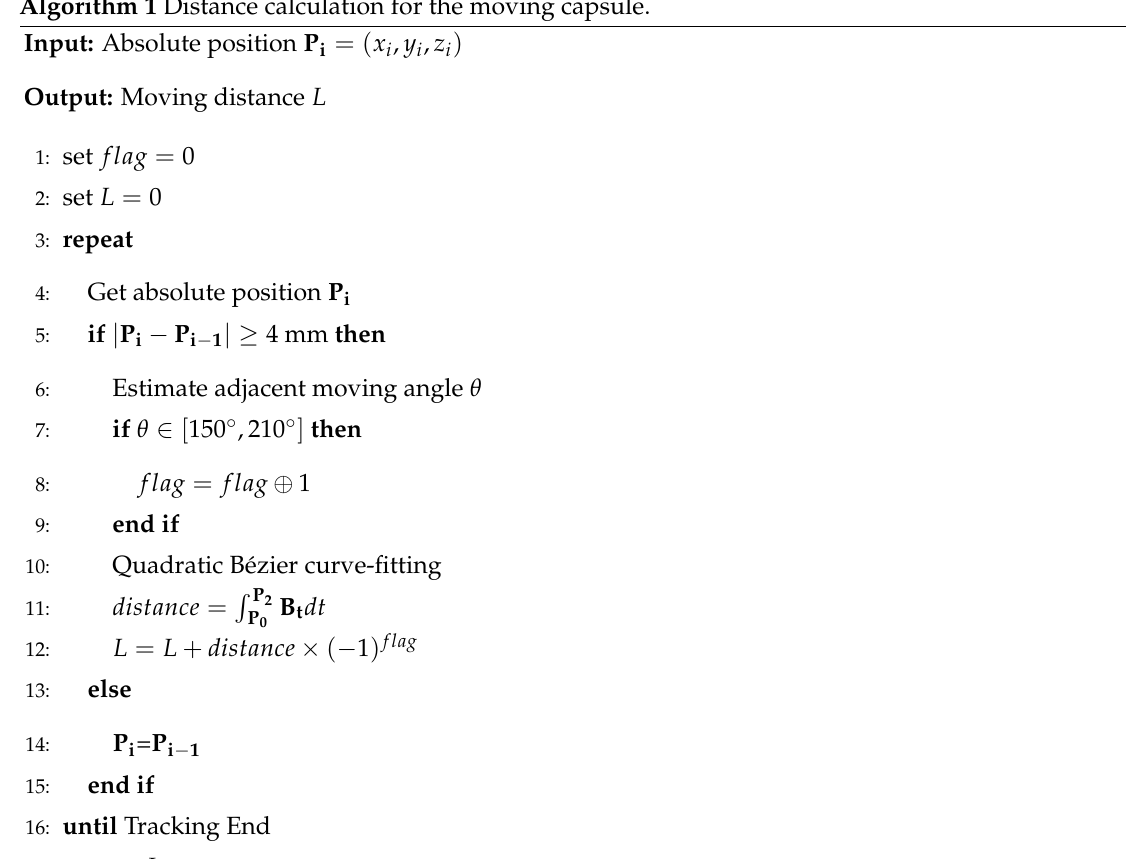
Algorithm 1 Distance calculation for the moving